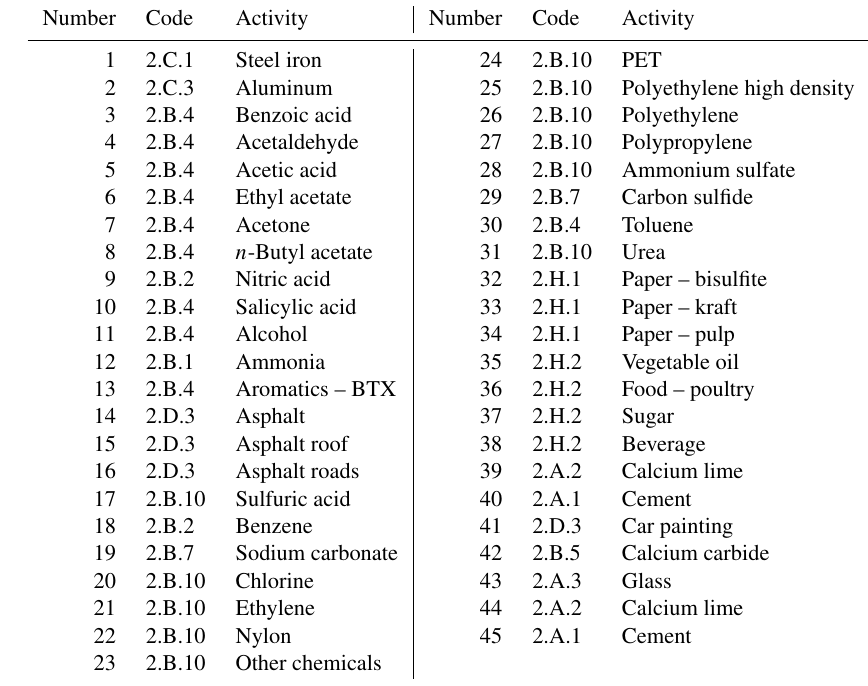
Table A3. List of industrial